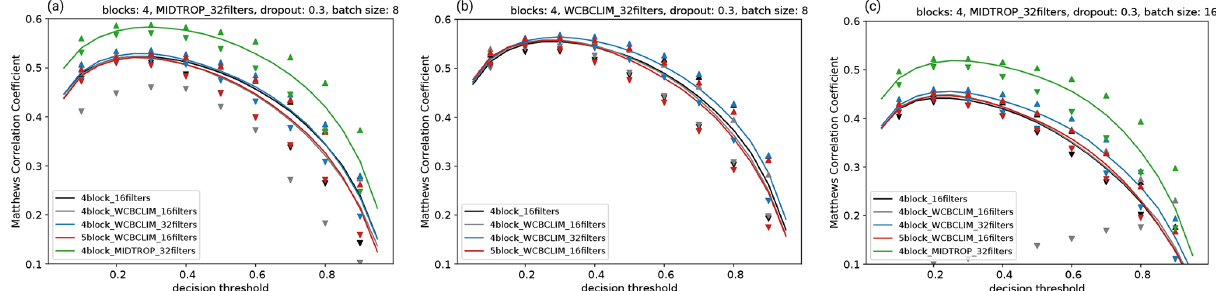
Figure 2. MCC values for (a) WCB inflow, (b) WCB ascent, and (c) WCB outflow as a function of the decision thresholds for different parameter settings described in Sect. 3.5 and listed in Table 3. MCC values are averaged over grid points for which the 30d running mean climatological WCB frequency reaches at least 1%. Lines are medians over all experiments with varied dropout fraction and batch size. Down- and up-pointing triangles denote their minimum and maximum values, respectively. The model configuration reaching the highest MCC is given in the title of each